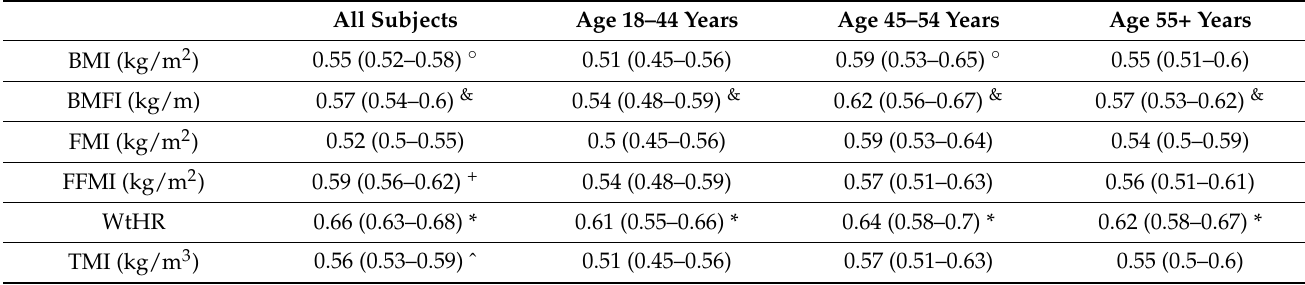
Table 4. Adjusted ROC area, relating anthropometric measure (95% CI) in all 1528 subjects and in the different age